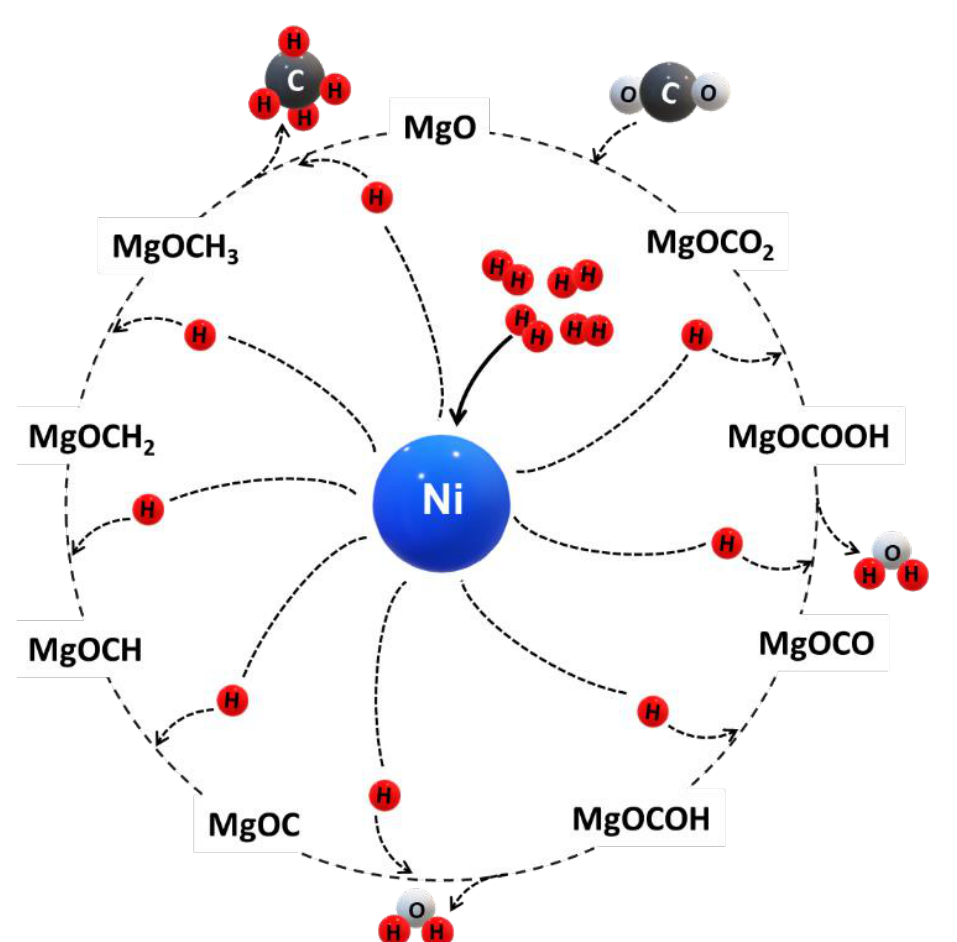
Figure 8. A potential bifunctional mechanism for Ni–MgO whereby spillover of atomic hydrogen from Ni in contact with MgCO 3 sequentially hydrogenates carbon until the product methane desorbs (adapted from Pd-Mg/SiO 2 catalysts from